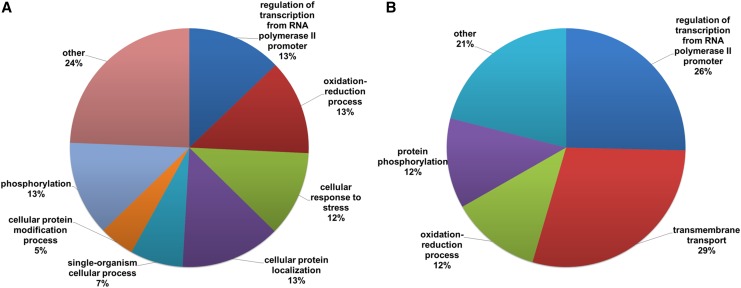
Gene Ontology analysis for genes on clusters (A) C2 and (B) C8 which are the largest up and downregulated gene clusters, respectively.